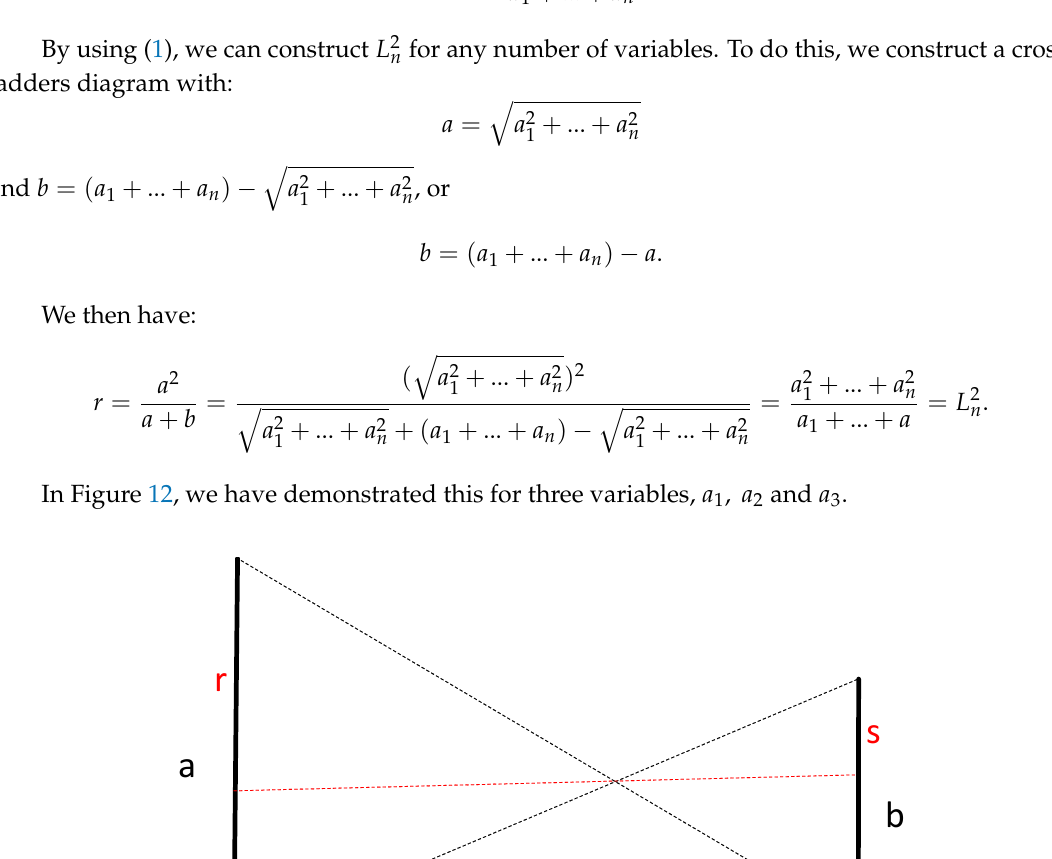
Figure 12. Geometric construction of r = L 2 Figure 12: Geometric construction of r = L 2